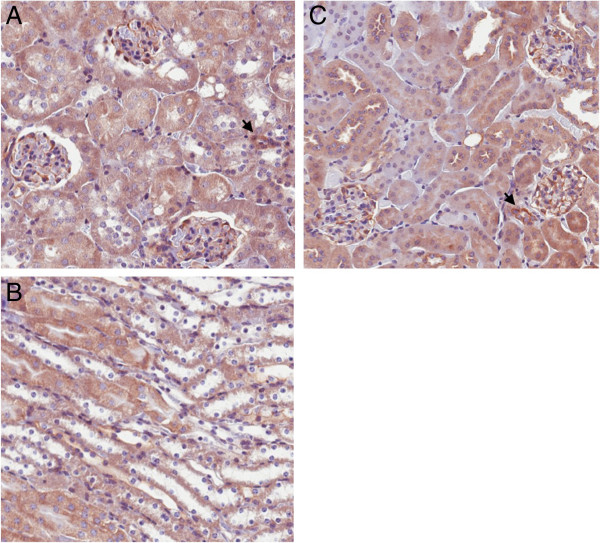
Representative photomicrographs of kidneys from Pax8-rtTA/LC1/floxed ETA (iETA) mice before and after doxycycline (DOX) treatment. Panel A shows cortex and Panel B shows medulla prior to DOX treatment; Panel C shows cortex after DOX treatment. DOX-treated iETA medullary staining is not shown since ETA immunostaining was not apparent in untreated iETA mice. Arrows indicate blood vessels. Staining was performed on 6 different mice of each genotype. Images are 200X.